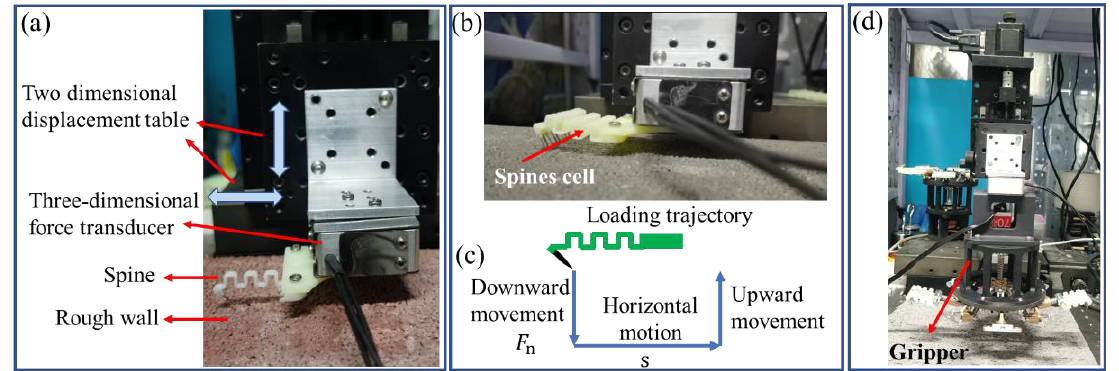
Figure 5. Experimental testing apparatus. ( a ) Attachment forces test of a spine. ( b ) Attachment forces test of a spine cell. ( c ) Loading trajectory of attachment test. ( d ) Attachment forces test of a gripper.